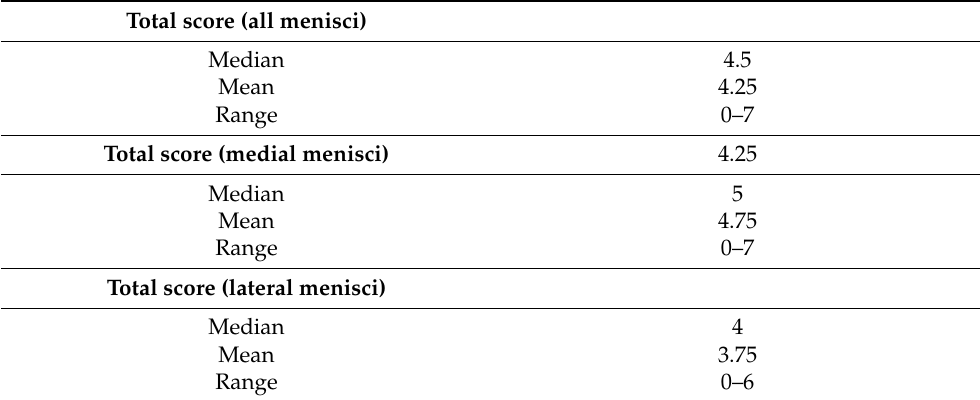
Table 2. Statistical values of total histological score for medial and lateral menisci.